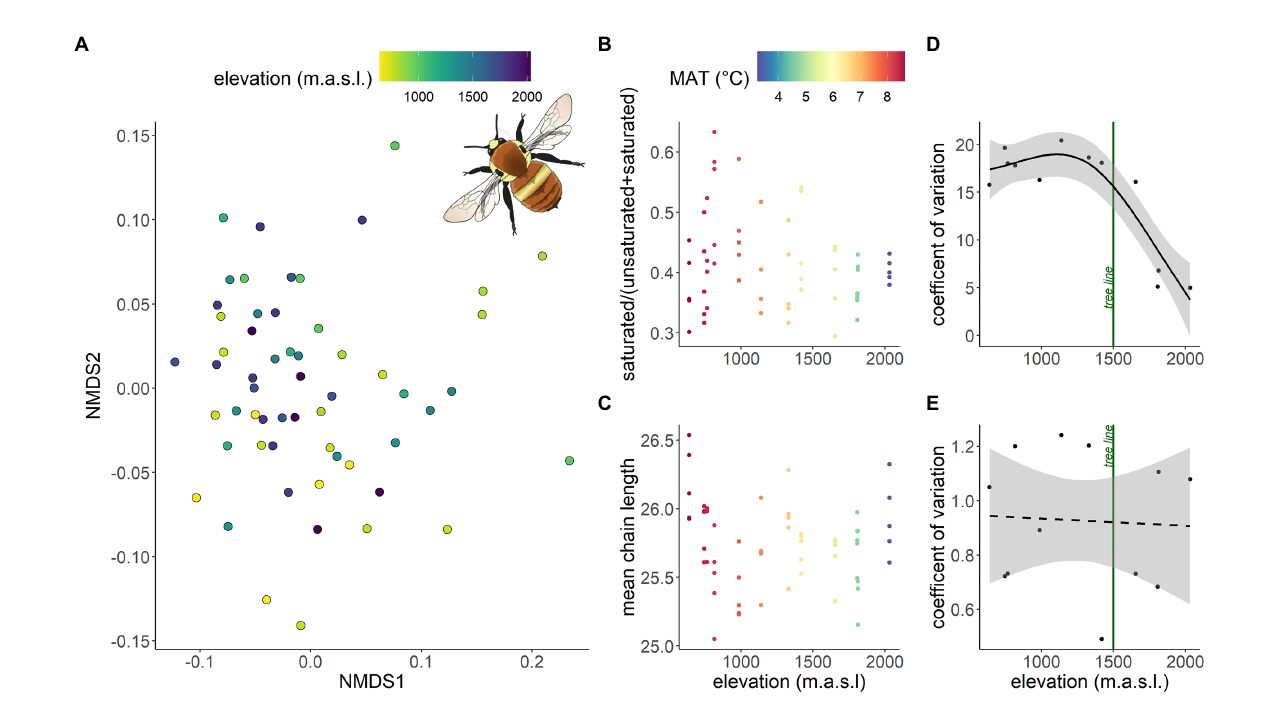
FIGURE 4 Intraspecific CHC variation of Bombus pascuorum workers along the elevational gradient. (A) Similarity of CHC profiles of individuals displayed in a two- dimensional graph by non-metric multidimensional scaling (NMDS) based on Bray-Curtis distances. Dots represent CHC profiles of individuals, dot colors the respective elevation. The closer the dots, the more similar the CHC profile. NMDS revealed a significant elevational effect on CHC profile composition but with a high degree of unexplained variance between samples. (B) The proportion of saturated components along the elevational gradient, dot colors represent mean annual temperature (=MAT), which was highly correlated with elevation (Person’s R = 0.99). (D) Coefficient of variation of the proportion of saturated components, green line represents the tree line. (C) Mean chain length along the elevational gradient, dot colors represent mean annual temperature (=MAT) and respective coefficient of variation (E) .